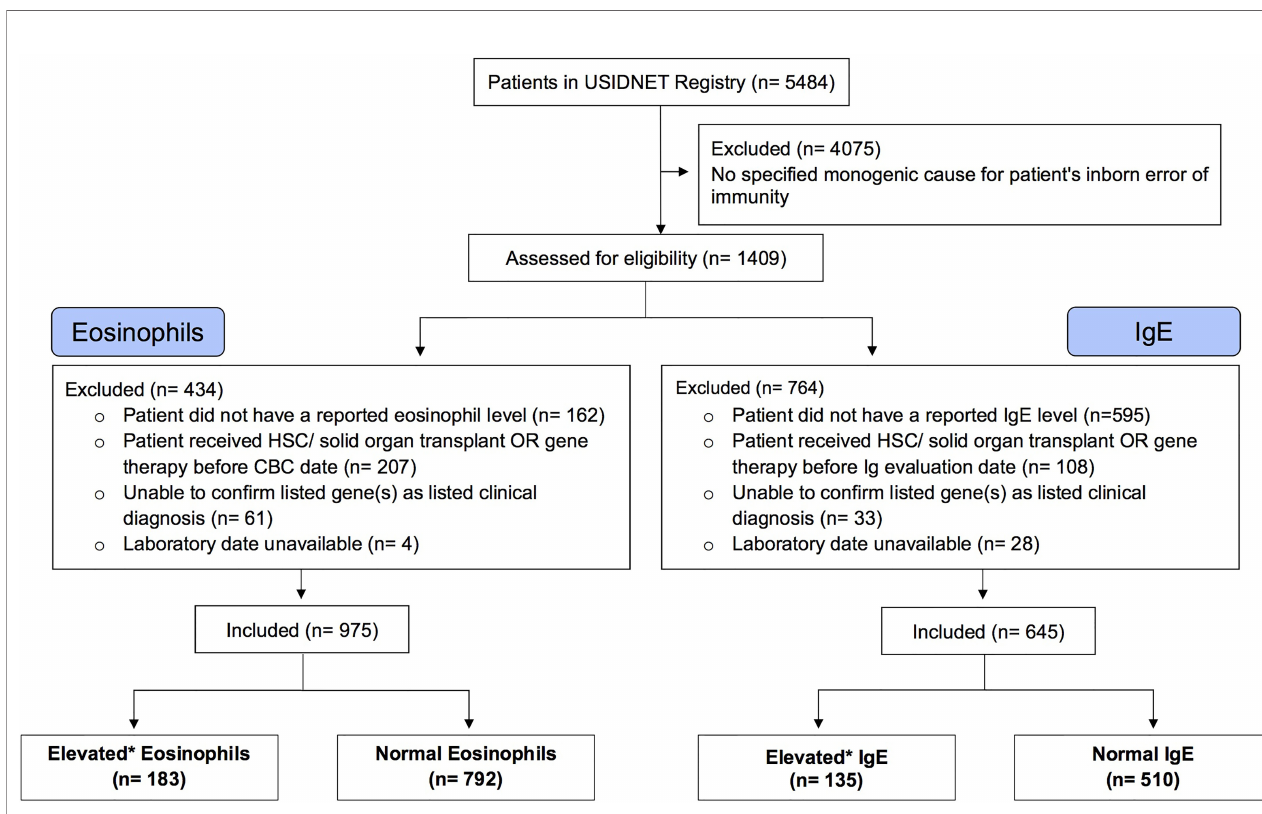
FIGURE 1 | Selection of Eligible Patient Cohort. A consort diagram describing review of the USIDNET Registry data and selection of eligible patient data for analysis. USIDNET indicates United States Immunode fi ciency Network; HSC, Hematopoietic stem cell; Ig, Immunoglobulin; CBC, complete blood count. *Elevated based on age-based reference